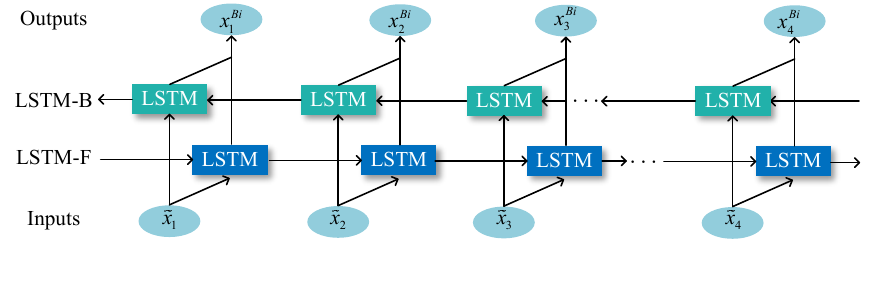
Figure 3. BiLSTM